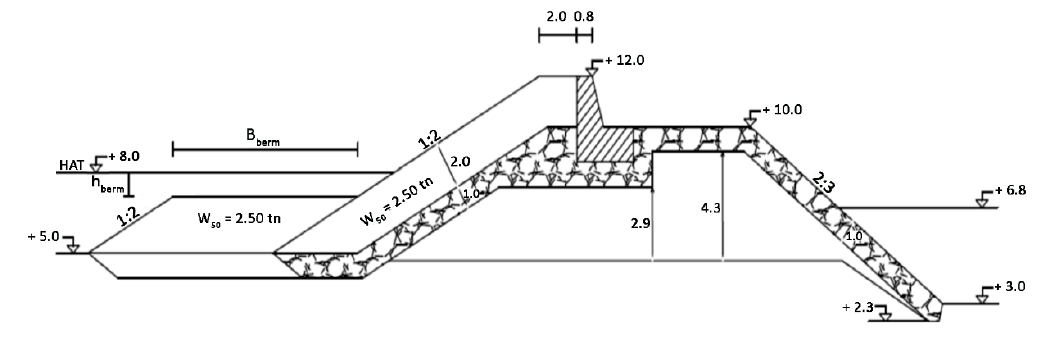
Figure 12. Cross-section of the studied rubble mound breakwater in Deauville, France for mitigation option 3.